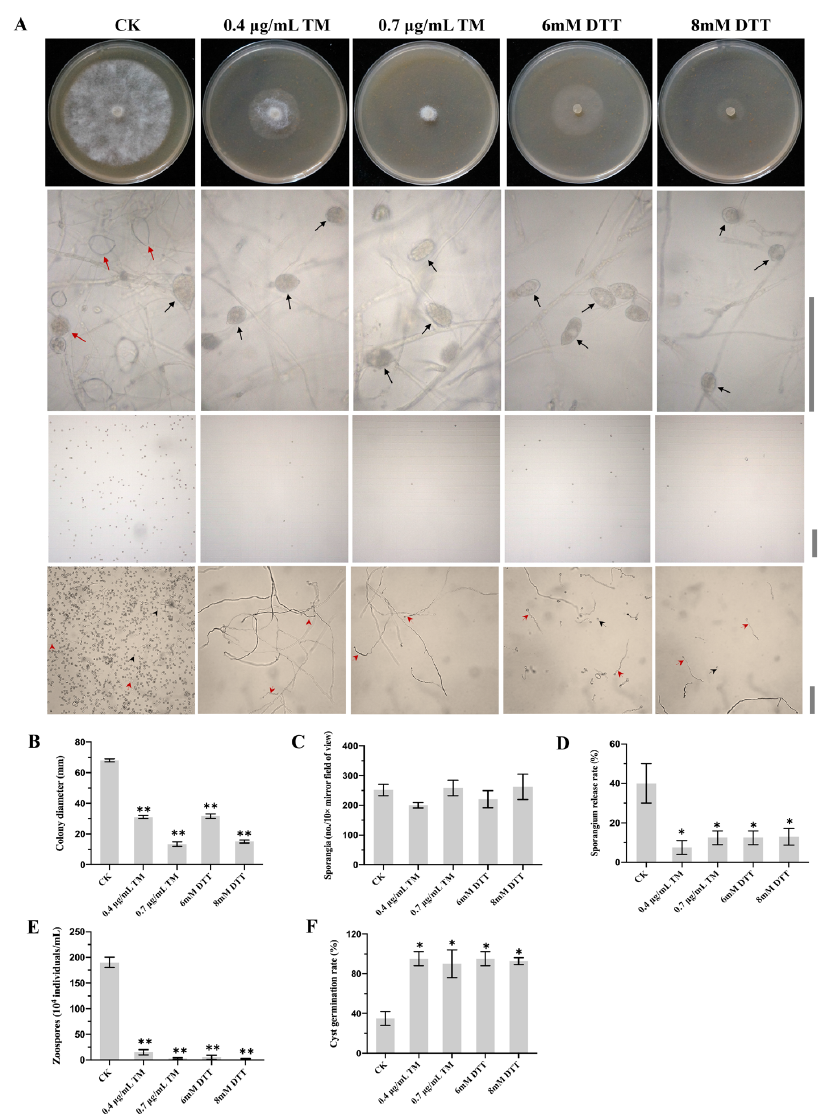
Figure 1. Effects of N - glycosylation inhibitor Tunicamycin (TM) and ER stress inducer dithiothreitol (DTT) on the development of Phytophthora capsici . ( A ) Mycelial growth on agar plates, microscopic visualization of sporangium production, zoospore release and cyst germination supplemented with TM (0.4 µg/mL or 0.7 µg/mL) or DTT (6 mM or 8 mM). Red solid line arrows represent released sporangia . Black solid line arrows represent unreleased sporangia. Red dashed arrows represent germinated cysts . Black dashed line arrows represent ungerminated cysts. Bar = 100 µm. ( B ) Colony diameters of different strains cultured for 3 days on V8 agar plates supplemented with TM or DTT. ( C ) Sporangium productions of all strains under a light microscope at 10 × mirror magnification. ( D ) Sporangial release rates of different strains. ( E ) Zoospore productions of different strains. ( F ) Cyst germination rates of different strains. Data represent the mean ± standard deviations from three biological repeats. Asterisks indicate a significant difference compared to the untreated control (CK) (*, p < 0.05; **, p <